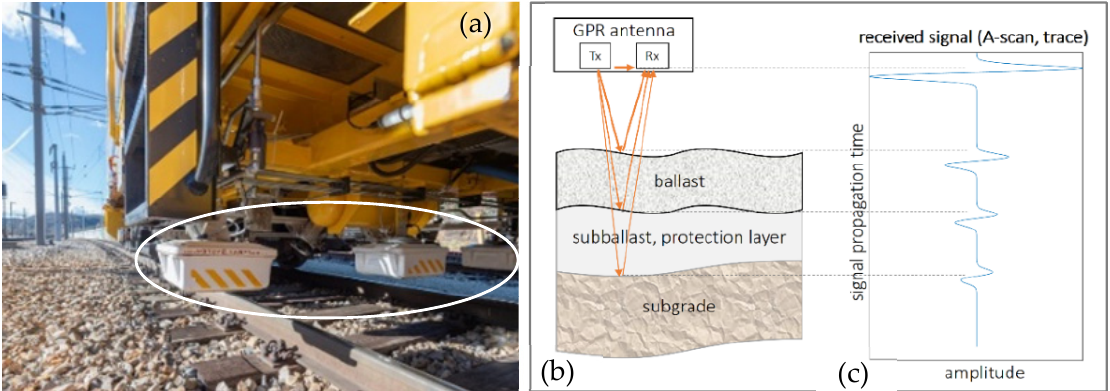
Figure 1. ( a ) Three GPR transducers mounted on a rail vehicle (indicated by the white ellipse), ( b )